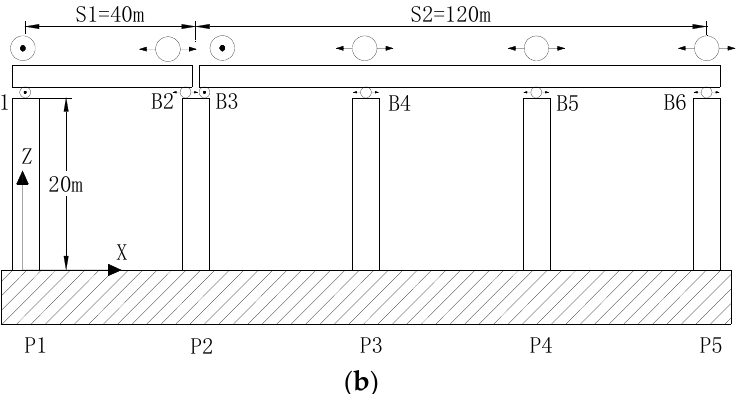
Figure 1. Analytical model of the viaduct. ( a ) Plan view of the curved highway viaduct model. ( b ) Elevation view of the curved highway viaduct model.